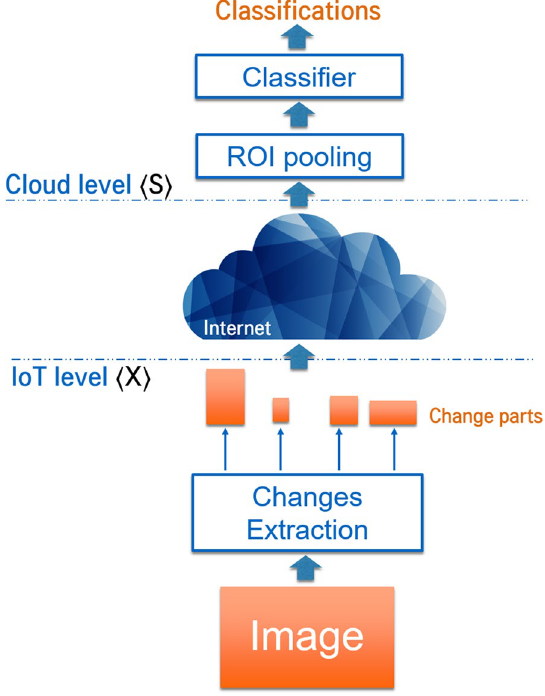
Fig. 4 Faster R‑CNN partitioning to fit our proposed